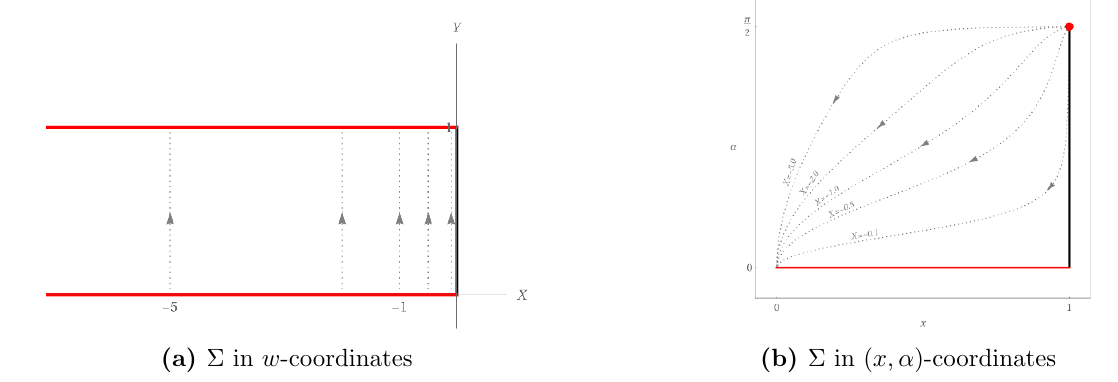
Figure 1. Showing (cid:6) in di(cid:11)erent in coordinate